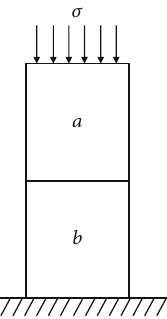
Figure 2: Coal-rock combination uniaxial loading model.